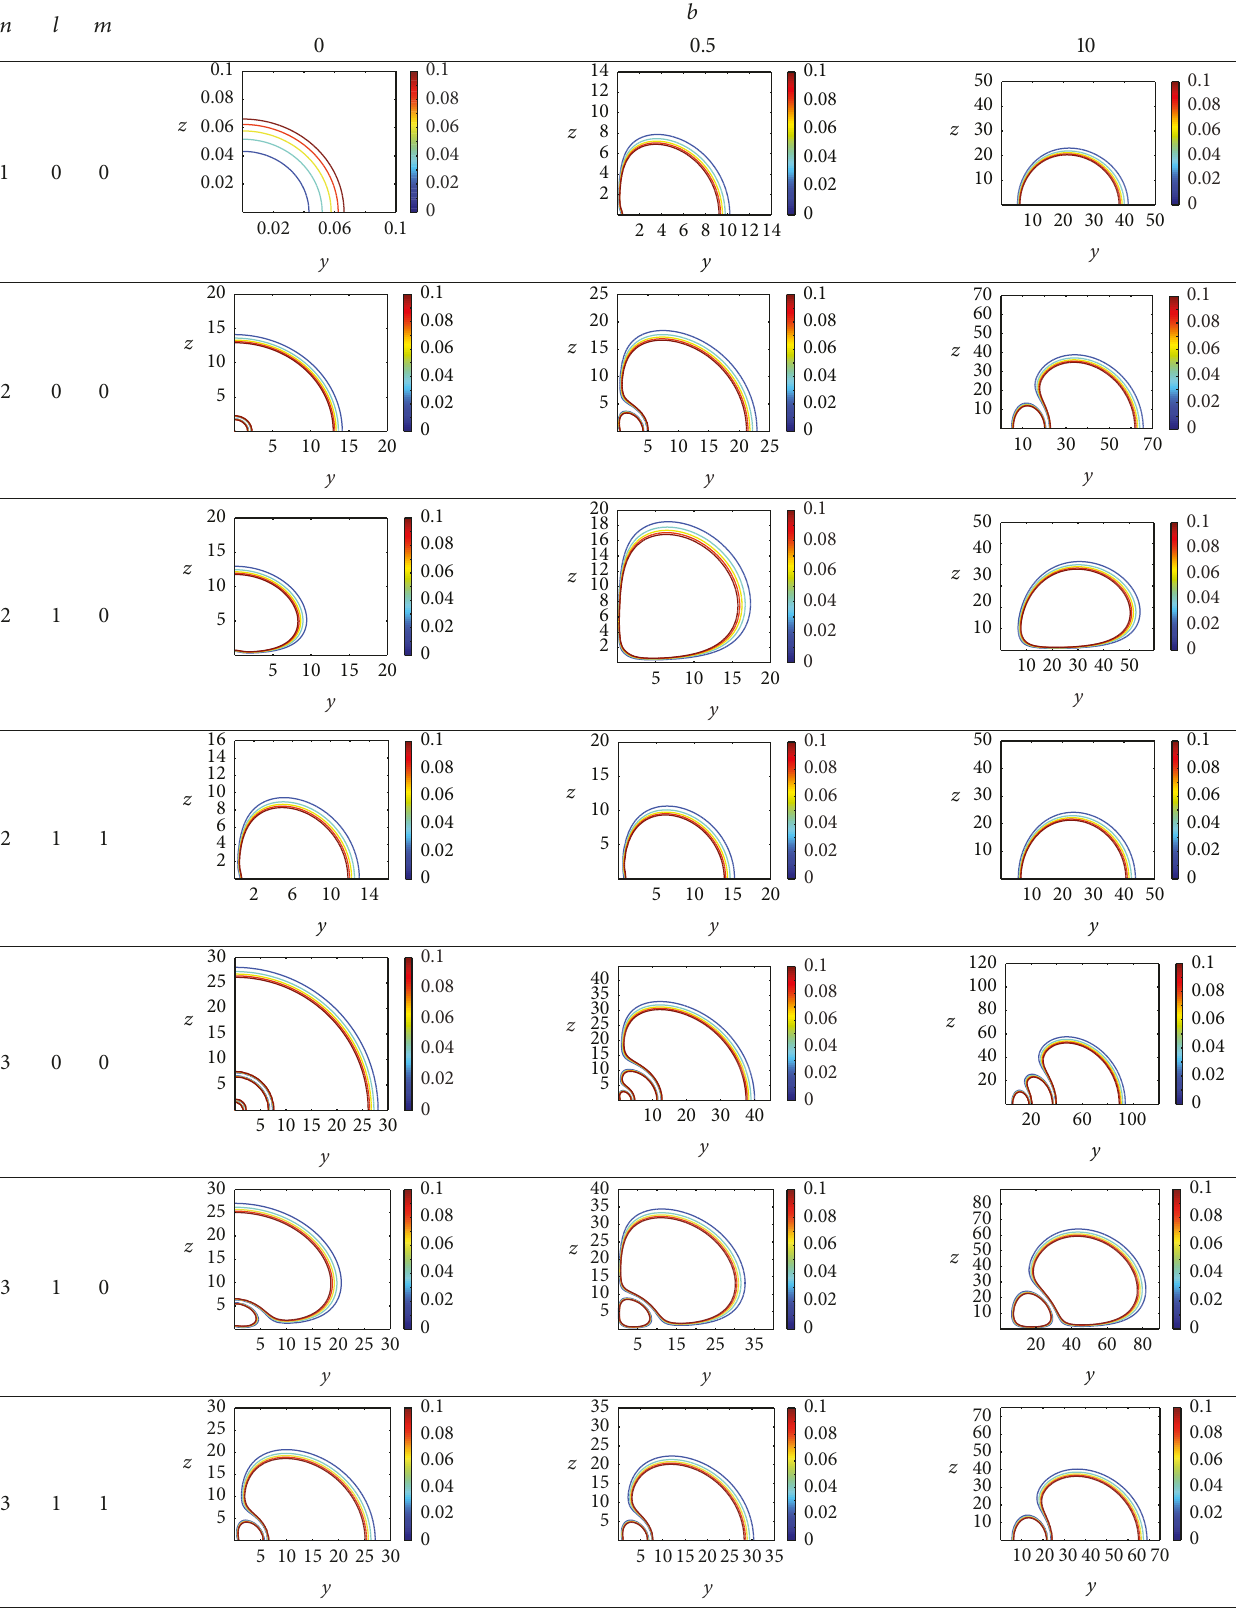
Table 3: Contour of the space probability distribution in two-dimensional plane yoz